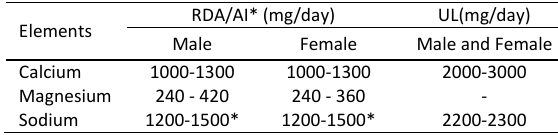
Table 5: Dietary Reference Intakes for selected nutrient minerals